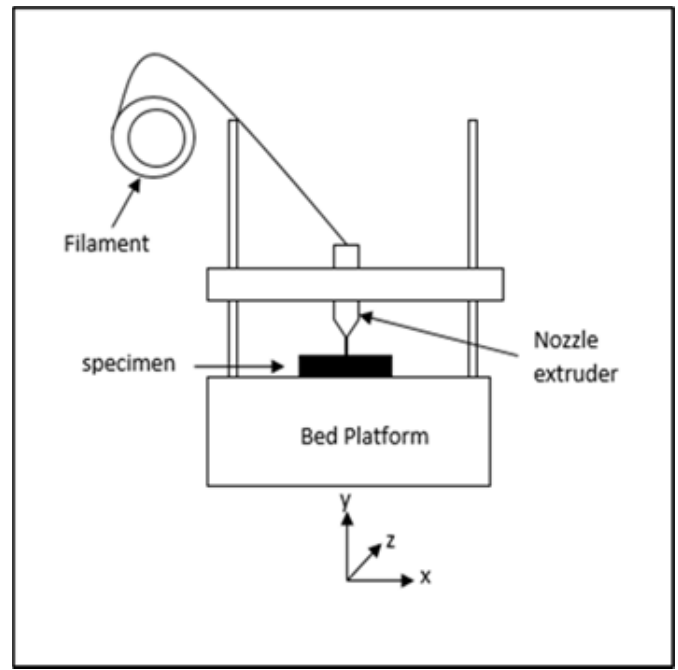
Figure 3. Schematic 3D printing process.